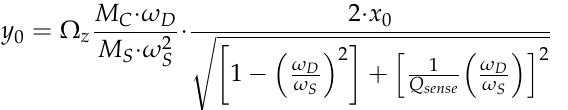
Figure 10. Mesh convergence study for MEMS gyroscope simulation. The GA optimization process is applied to the MEMS gyroscope for 6 generations. The FOM is defined by Equation